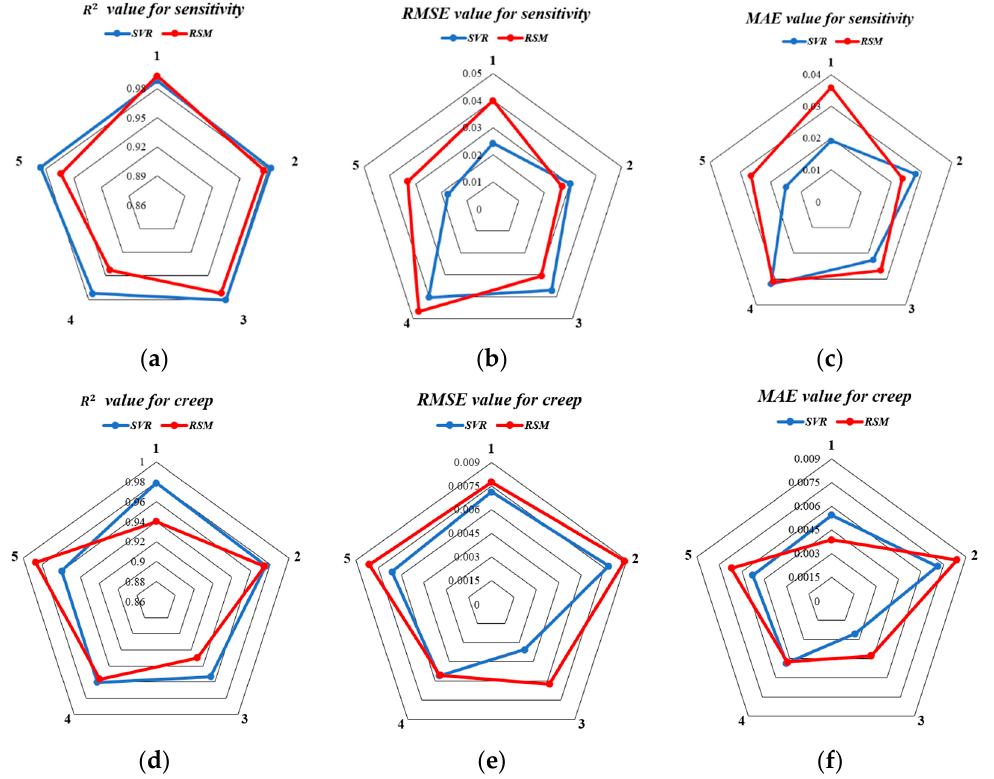
Figure 12. Radar diagrams of the five-fold cross-validation for the two estimation models in terms of R 2 , RMSE , and MAE for sensitivity and creep. ( a ) R 2 value for sensitivity; ( b ) RMSE for sensitivity; ( c ) MAE for sensitivity; ( d ) R 2 value for creep; ( e ) RMSE for creep; ( f ) MAE for creep.